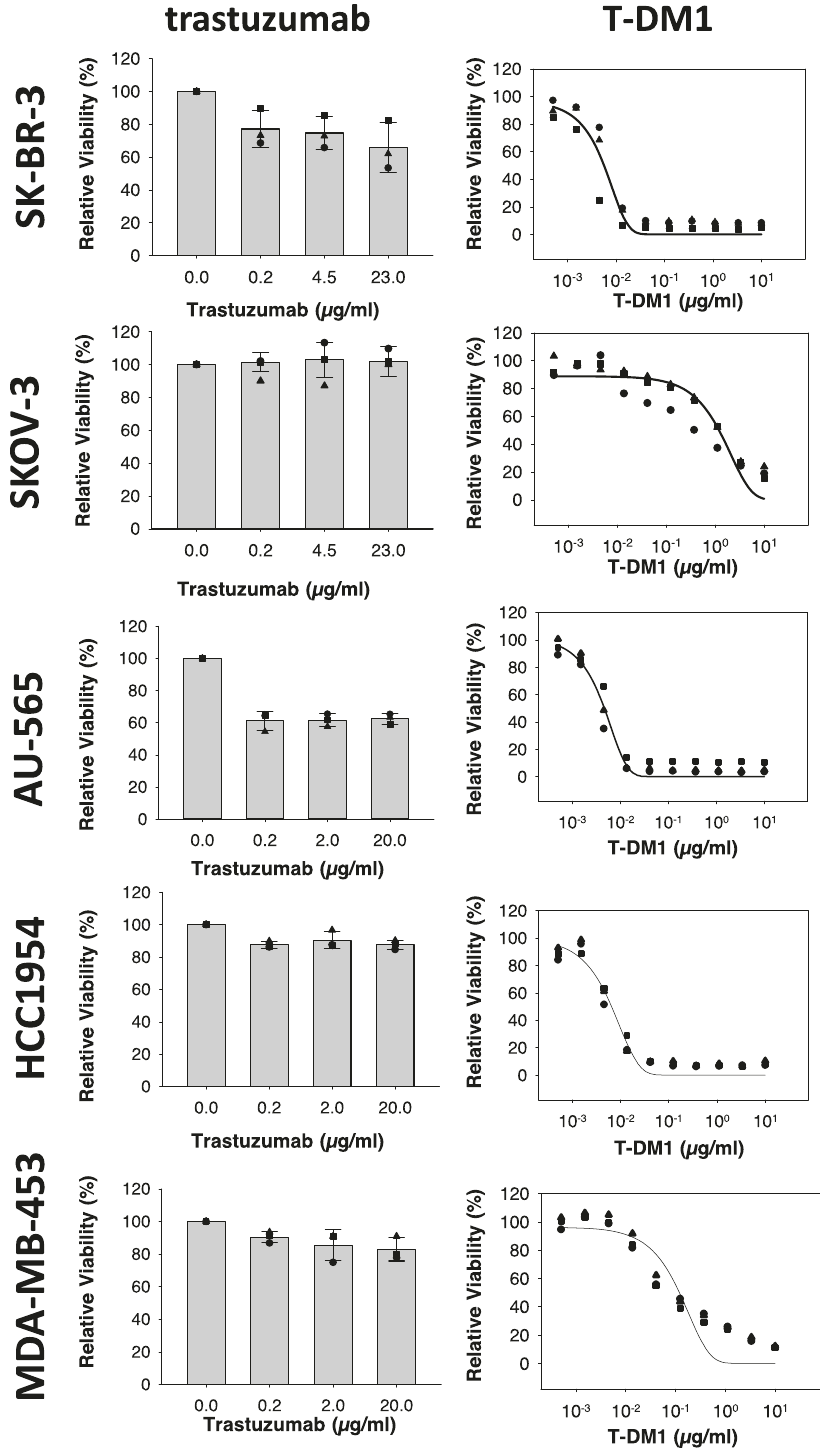
Fig. 1 In vitro sensitivity to trastuzumab and T-DM1. Relative viability (MTT) of SK-BR-3, SKOV-3, AU-565, HCC1954, and MDA-MB-453 following 72 h treatments with indicated drugs. The sigmoid curve fi t model a /(1 + exp( − ( x − x 0 )/ b )) was used for T-DM1. Data points represent the observed values of three independent experiments, the bar represents the average and the error bars represent the SD(trastuzumab). Source data are provided as a Source Data fi expression of RAB5A in this panel of cell lines, while no linear T-DM1 sensitivity was also correlated to the expression level correlation is found for RAB4A and RAB11A. The expression of HER2 and RAB5A together revealing an R 2 = 0.962 (Fig. 3D) which is higher than obtained with the correlations level of HER2 and RAB5A together serves as a better bio- of HER2 ( R 2 = 0.840) (Fig. 2C) and RAB5A ( R 2 = 0.934) marker for cellular T-DM1 response as compared to either of (Fig. 3A) alone. Thus, T-DM1 sensitivity correlates to the the two proteins alone.